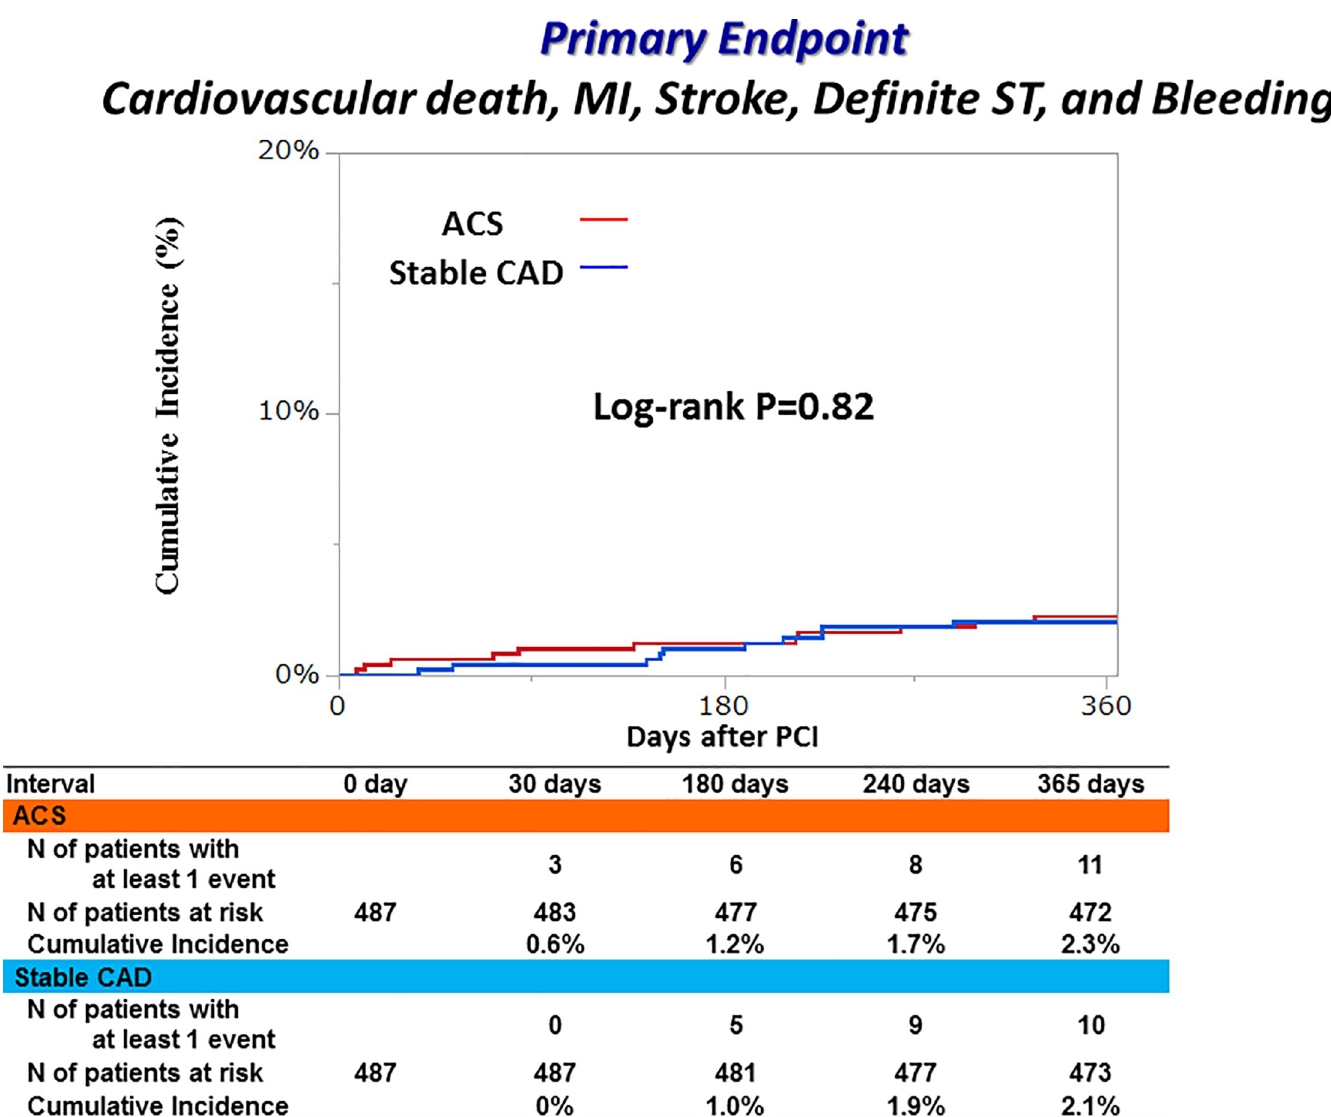
Fig 6. Clinical outcomes at 1-year in the propensity matched cohort. Event rates indicated the cumulative 1-year incidence estimated by Kaplan-Meier method. Primary endpoint was defined as a composite of CV death, MI, stroke, definite ST and TIMI major/minor bleeding. ACS, acute coronary syndrome; CAD, coronary artery disease; CV death, cardiovascular death; MI, myocardial infarction; ST, stent thrombosis; TIMI, Thrombolysis in Myocardial Infarction.